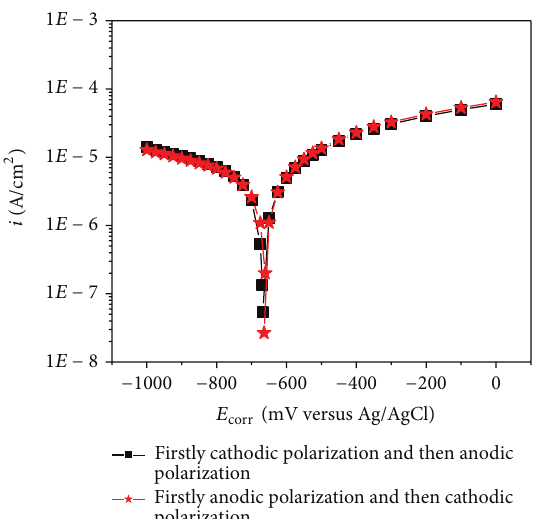
Figure 14: Polarization curves of steel immersed in distilled water for 3